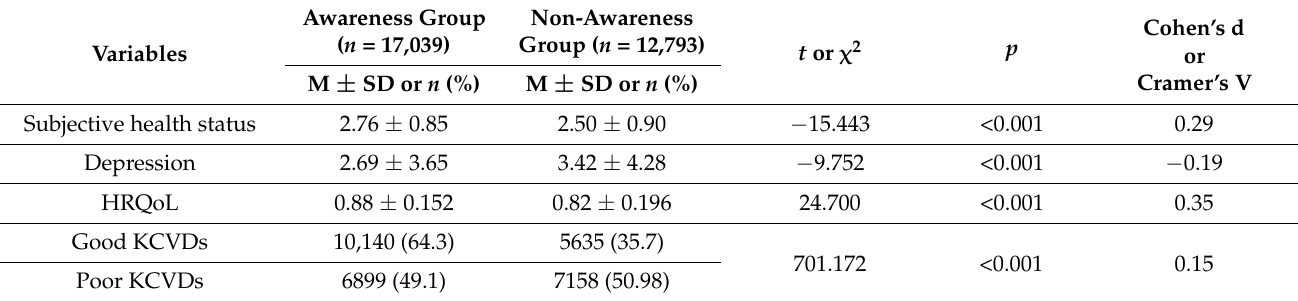
Table 2. KCVDs and psychological factors according to blood pressure level awareness.